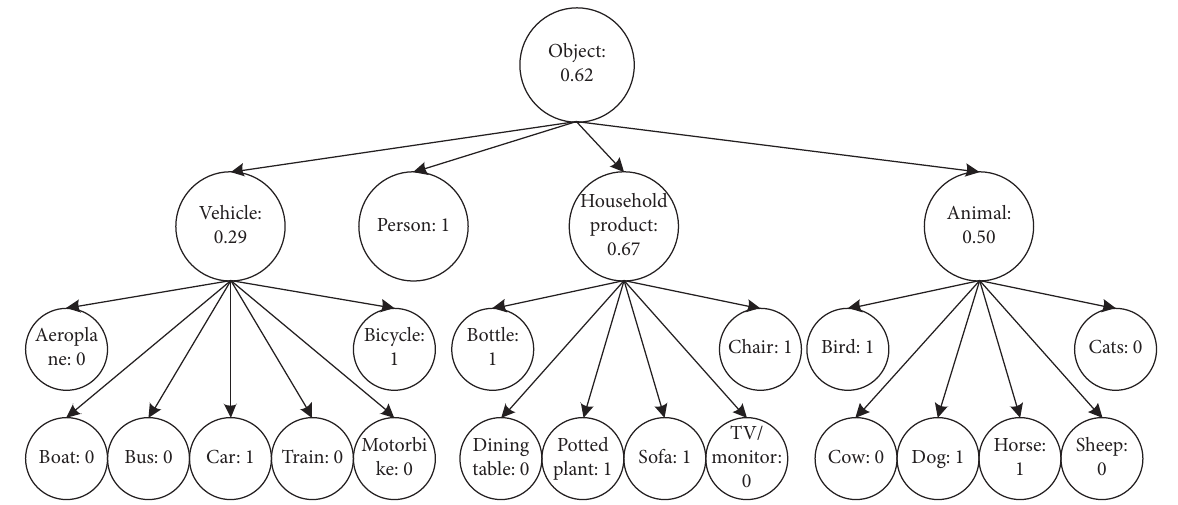
Figure 5: Semantic hierarchy tree and completeness of category for original PASCAL VOC 2007 training dataset. Table 8: Results of other quality dimensions for the selected images and its original training dataset of the PASCAL VOC 2007 dataset. Annotation quality dimension